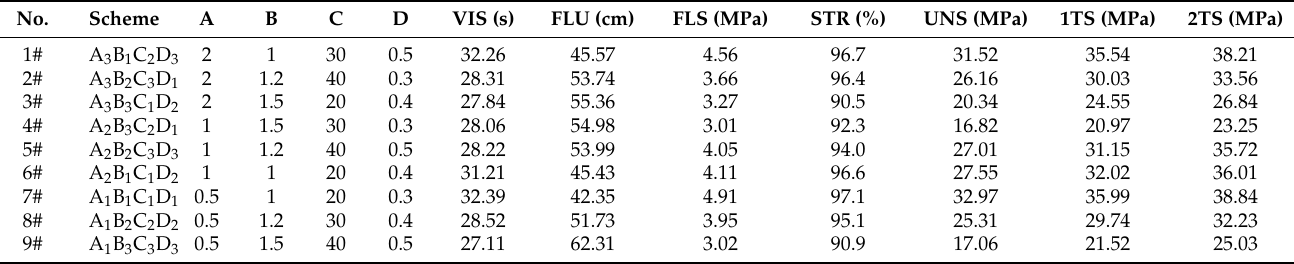
Table 5. Results and schemes of orthogonal